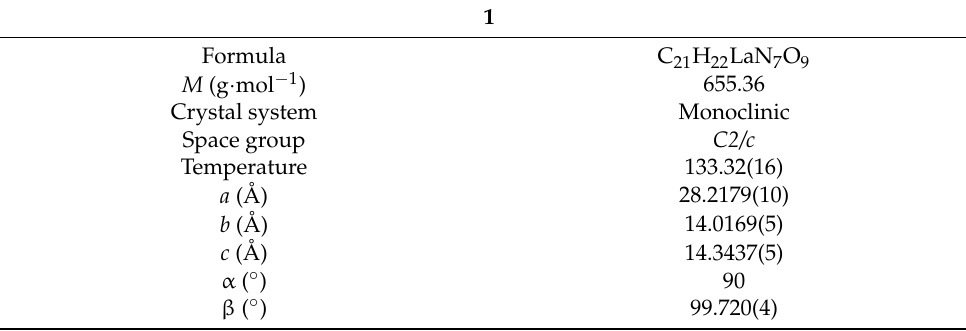
Table 2. Crystal Data and Structure Refinement Information for 1 .